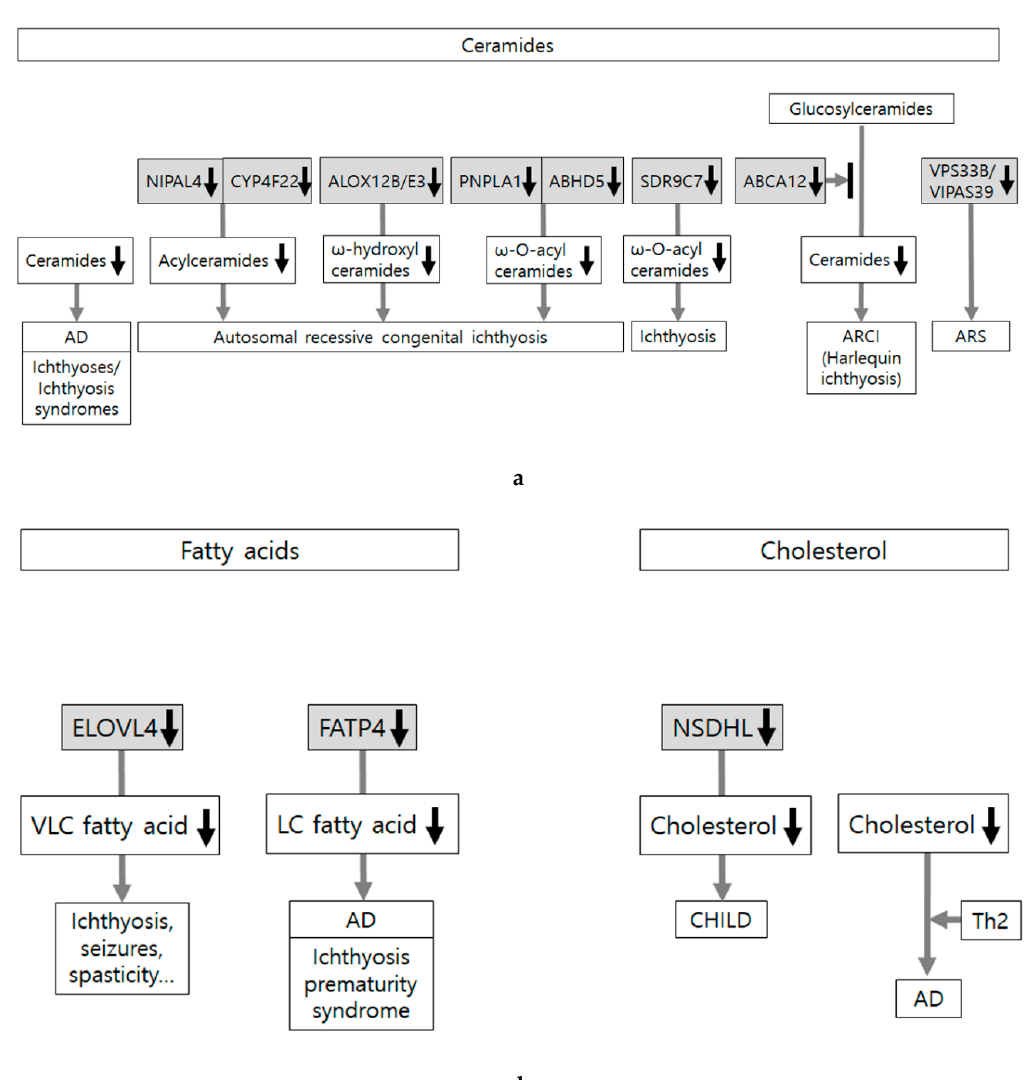
Figure 5. Skin lipid alteration in skin conditions showing epidermal barrier dysfunction. ( a ) Skin lipids are composed of ceramides, free fatty acids, and cholesterol. Abnormalities in lipid composition, transport, and extracellular organization induce abnormal lipid organization. Most of the reports are related to abnormalities in ceramides, which are associated with ichthyoses, ichthyosis syndromes, and atopic dermatitis (AD). Loss-of-function mutations in ABCA12 (ATP-binding cassette transporter A12) cause harlequin ichthyosis, the most severe phenotype of autosomal recessive congenital ichthyosis (ARCI). Loss-of-function mutations in NIPAL4 (NIPA like domain containing 4), CYP4F22, ALOX12B and ALOXE3, PNPLA1 (Patatin-like phospholipase domain-containing lipase 1), and ABHD5 ( α / β hydrolase domain-containing protein 5) also cause ARCI. ( b ) Not much has been reported about the association between altered synthesis of free fatty acid / cholesterol and skin barrier dysfunction. Loss-of-function mutations in ELOVL4 (fatty acid elongase 4) and FATP4 (fatty acid transport protein 4) reduce very long-chain (VLC) or LC fatty acids and cause neurocutaneous disorder (characterized by ichthyosis, seizures, spasticity, intellectual disability, and ichthyosis) and ichthyosis prematurity syndrome, respectively. Although loss-of-functionmutationsinNSDHL(NADP-dependent steroid dehydrogenase-like) inhibit cholesterol synthesis and cause CHILD syndrome (Congenital Hemidysplasia with Ichthyosiform Erythroderma and Limb Defects), cholesterol depletion is not considered as adequate to induce atopic dermatitis-like alteration in the absence of Th2